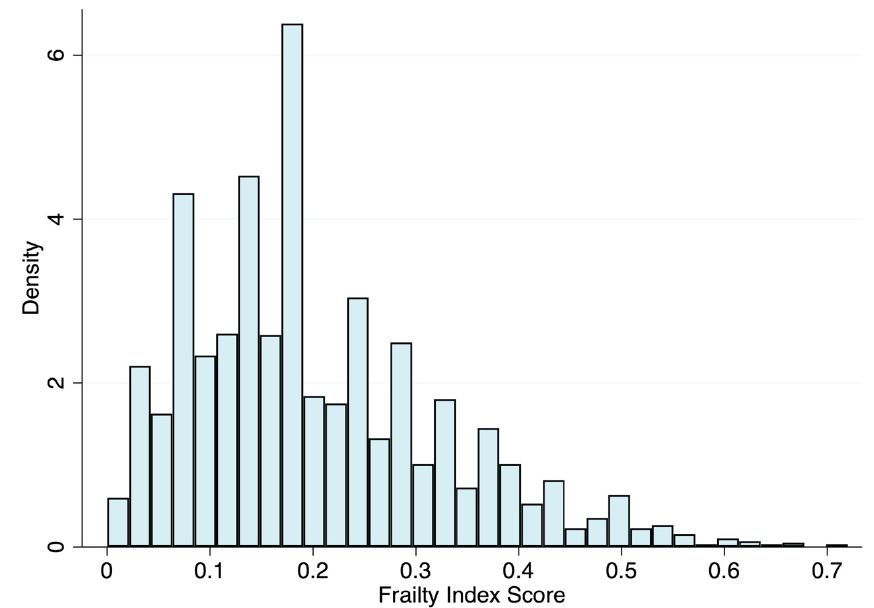
Figure 1. Distribution of the 36-item frailty index. Table 1. Baseline characteristics of the study participants by frailty status (N = 2661).